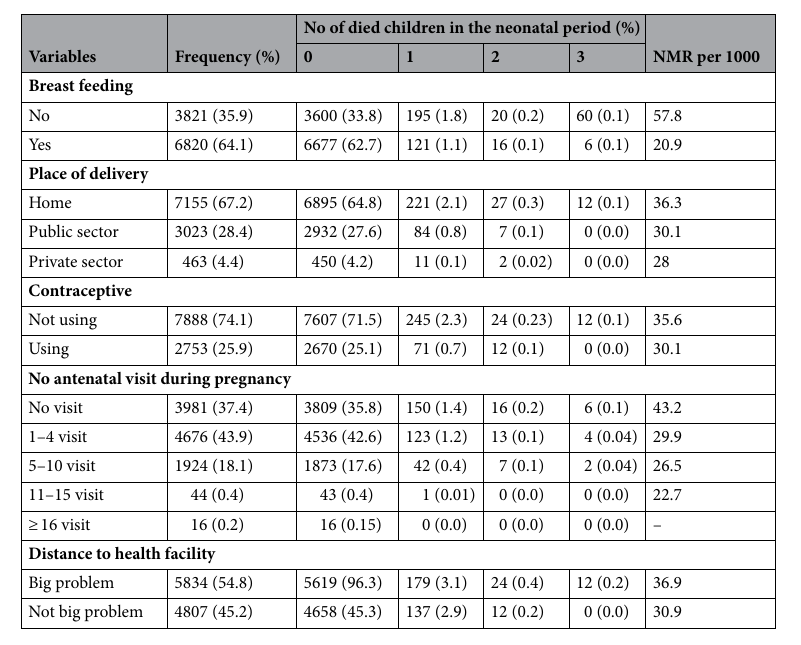
Table 4. Health care service